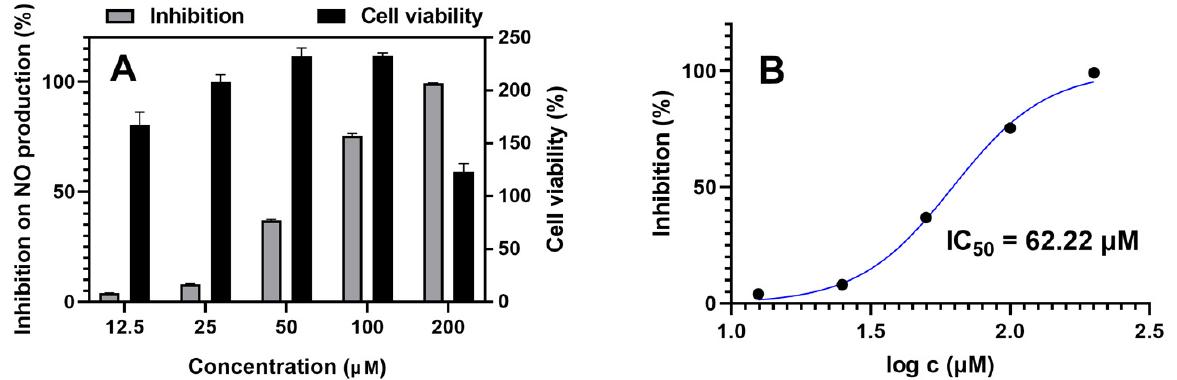
Figure 8. Anti-inflammatory activity assay using LPS-induced RAW264.7 cells. ( A ) Concentration effects of compound 9 on NO formation of LPS-induced RAW264.7 cells and on the viability of RAW264.7 cells, n = 3. ( B ) IC50 of compound 9 on inhibition of NO production in LPS-stimulated RAW264.7 cells, concentrations were transferred to Log(c).